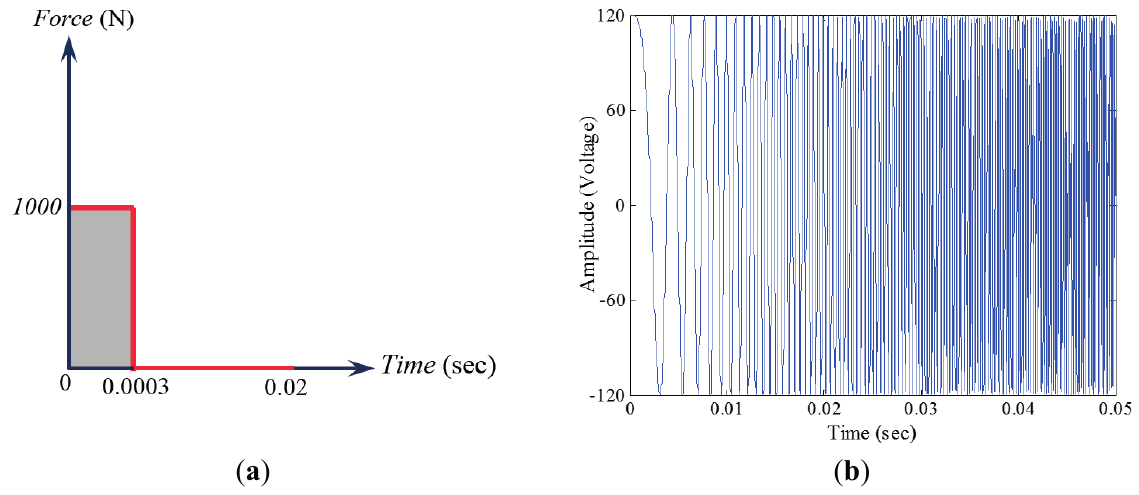
Figure 4. Schematic representations of ( a ) the impact and ( b ) the chirp